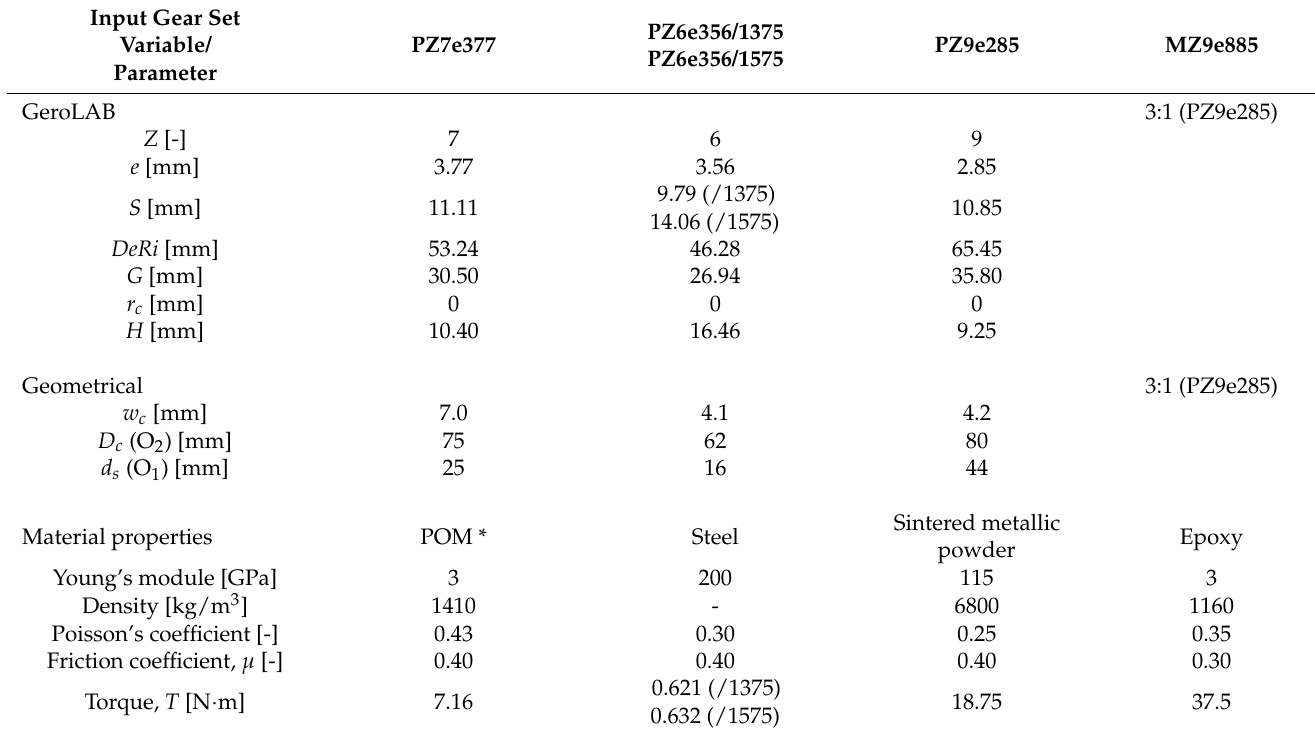
Table 2. Geometrical and technical parameters of gear sets (please refer to Nomenclature section and Figure